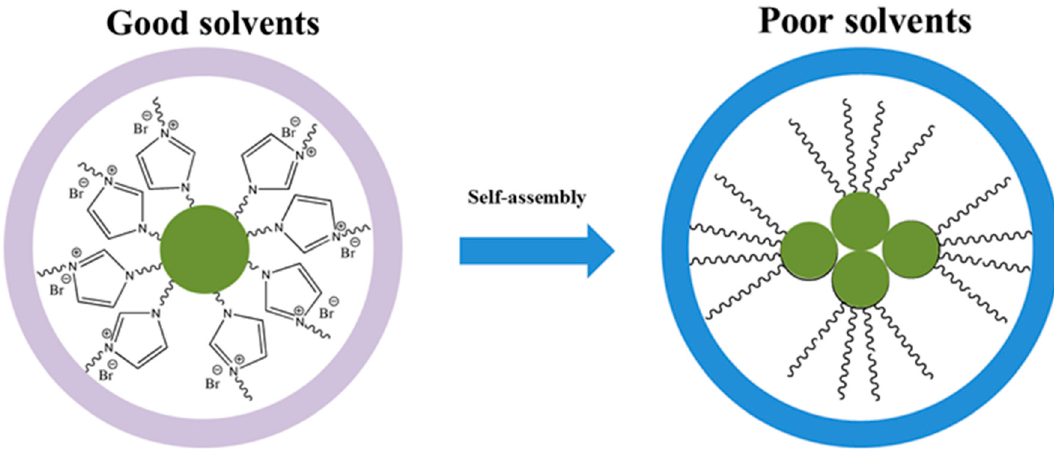
Figure 2. Emission spectra of IL-POSS-Br ( a ) and IL-POSS-Cl ( b ) (1 × 10 − 6 M).